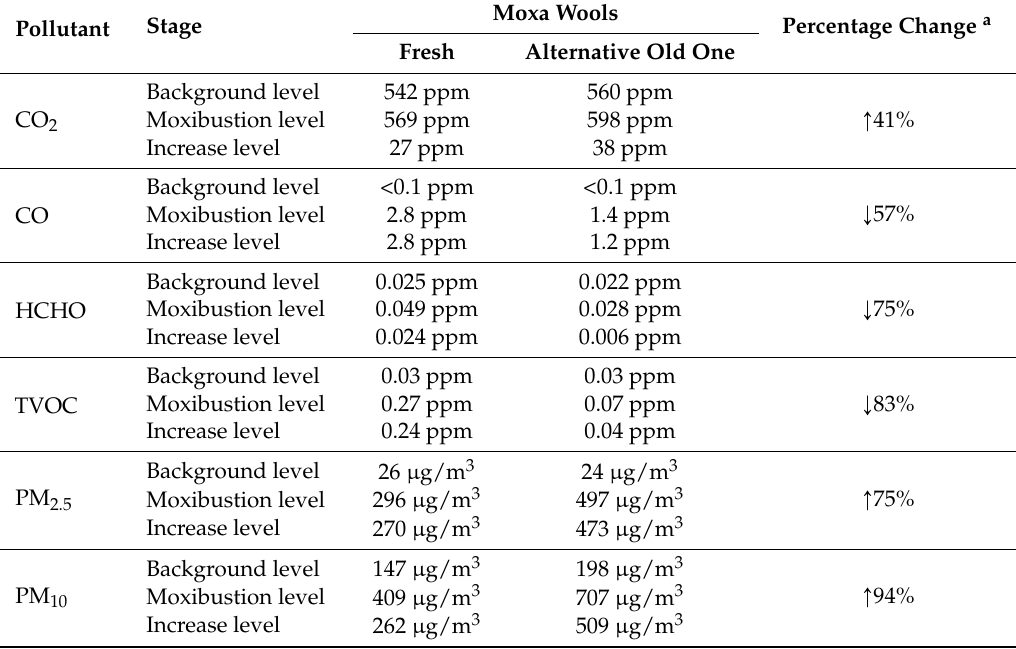
Table 1. Comparison between average values of mean levels of air pollutants emitted from burning new moxa wools and alternate old moxa wools.